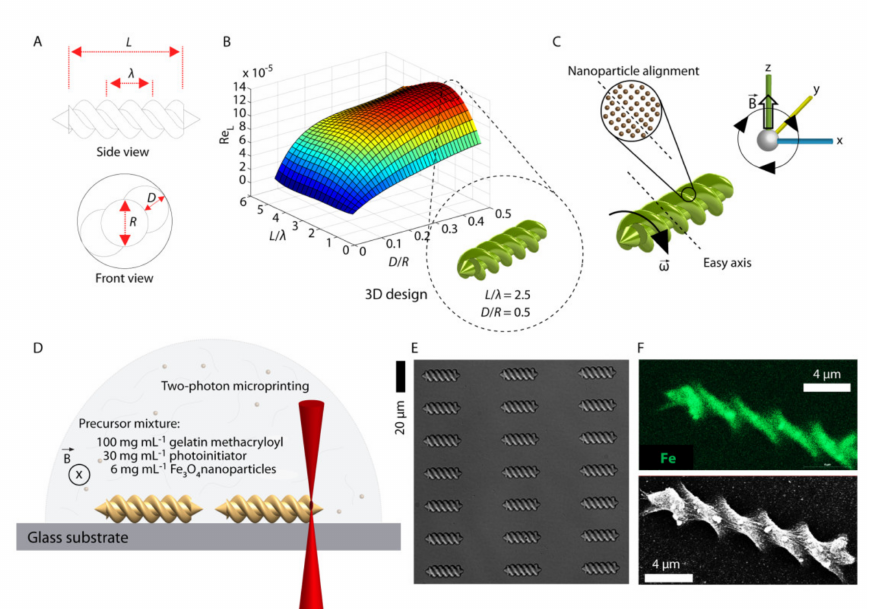
Figure 2. Diagrammatic representation of designing and 3D printing-based fabrication of biodegrad- able hydrogel microswimmers. ( A ) Empirical design of the double-helical microswimmer. ( B ) Com- putational fluid dynamics simulation for Reynolds number with respect to L/ λ and D/R ratios, calculated for water at room temperature. The maximum forward swimming velocity was found with L/ λ = 2.5 and D/R = 0.5 for the given design-space sweep study. ( C ) Alignment of the magnetic nanoparticles that defines an easy axis normal to the helical axis, thereby allowing rotational motion under rotating magnetic fields. ( D ) Three-dimensionalfabrication of the microswimmers using two- photon polymerization. During the fabrication process, a continuous magnetic field was applied to keep the nanoparticles aligned. ( E ) Optical microscope differential interference contrast (DIC) image of a microswimmer array. ( F ) Energy-dispersive X-ray spectroscopy mapping of iron, confirming the homogeneous embedding of the iron oxide magnetic nanoparticles inside the microswimmer body. (Reproduced with permission from [21]).